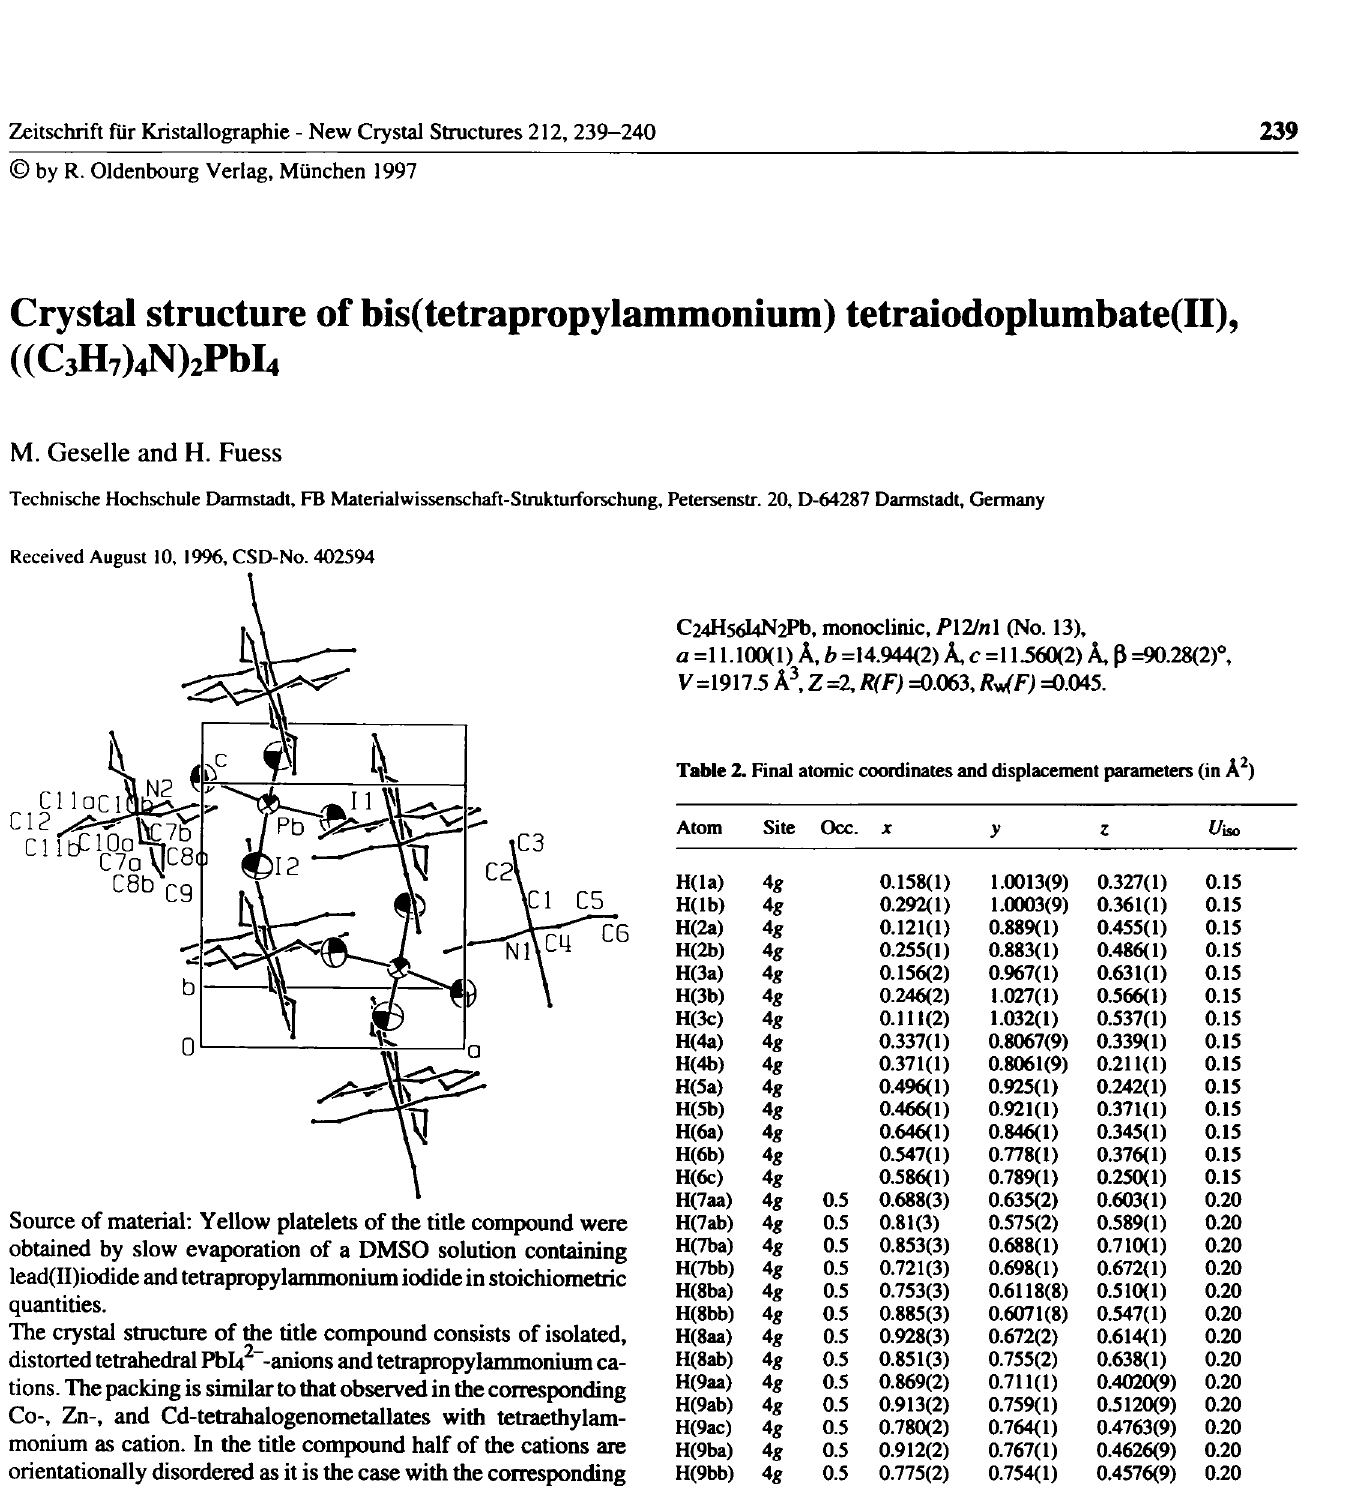
Table 1. Parameters used for the X-ray data collection Crystal: